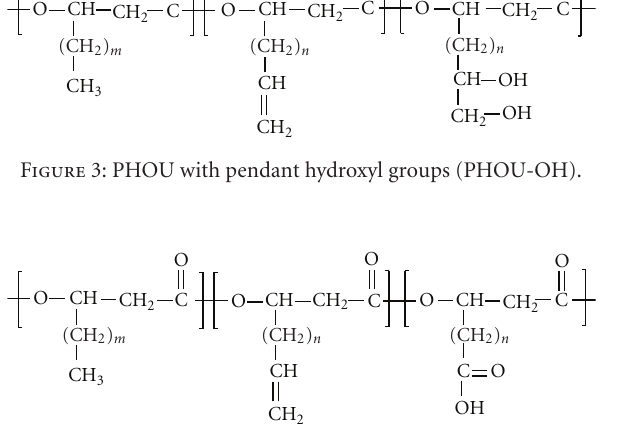
Enhenced hydrophilicity of the PHOU has recently been achieved by the reaction between epoxidized PHOU and diethanol amine to give highly hydrophilic polyester, PHON [42]. The first reaction involved the transformation of the vinyl-terminated side chains of PHOU to epoxide groups (PHOE). Figure 5 shows the conversion reaction of epoxidized PHOU (PHOE) to hydroxylated PHOU in the presence of diethanol